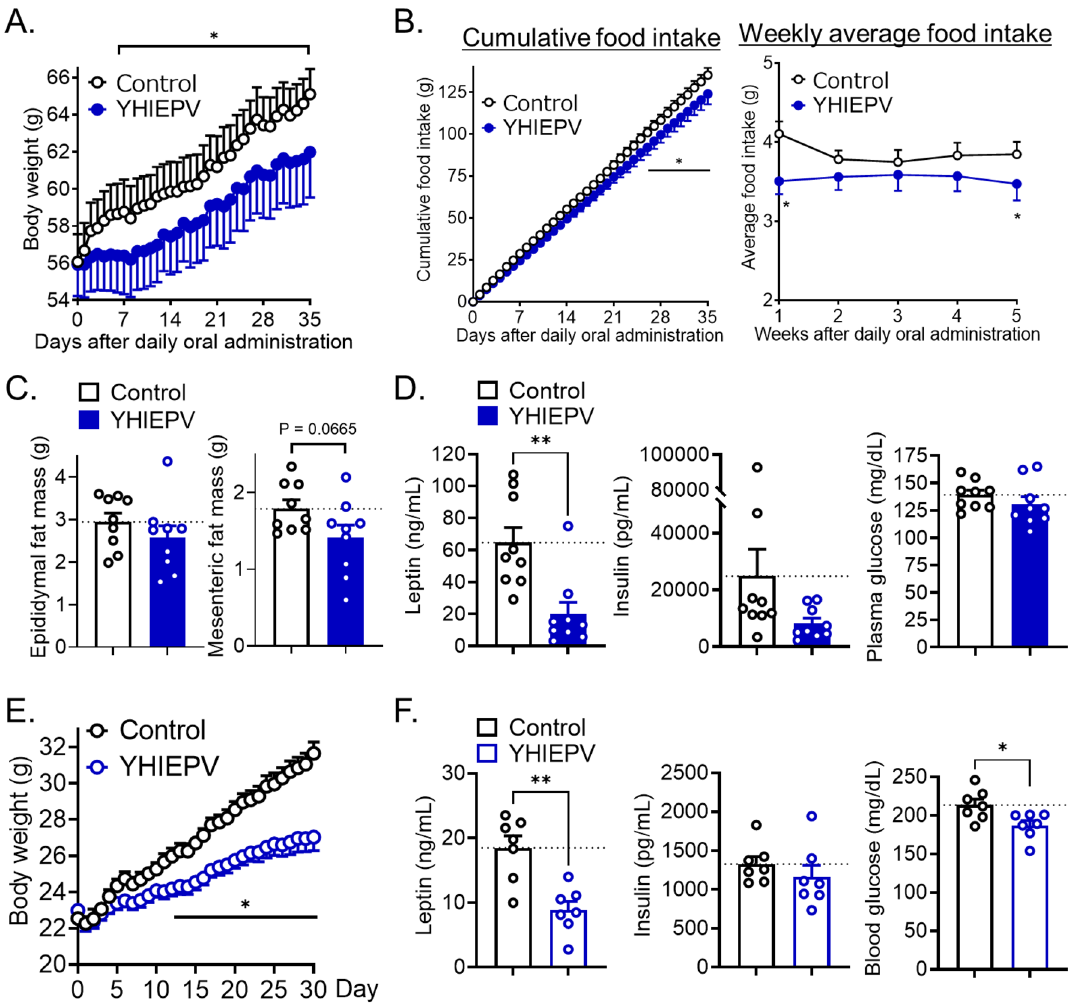
Figure 3. YHIEPV protects against dietary obesity. ( A – D ) Effects of YHIEPV on body weight and food intake in HFD-induced obese ddY mice. Body weight changes ( A ) and cumulative food intake or weekly average food intake ( B ). HFD-fed obese ddY mice (HFD for 2 months, n = 9/group) were orally administered YHIEPV (0.3 mg/kg for 35 days) once a day. Epididymal and mesenteric fat masses ( C ) and plasma leptin, insulin, and glucose levels ( D ) were measured on day 35. Mice were fasted for 3 h (from 8 to 11AM) before the collection of tissue and blood samples. ( E , F ) YHIEPV was centrally infused (1 μg, every day) into C57BL/6 mice (n = 7). HFD was initiated on day 0. Body weight ( E ) was measured daily. Plasma levels of leptin and insulin and blood glucose levels ( F ) were measured on day 30. Mice were fasted for 3 h (from 8 to 11AM) before the collection of blood samples. *p < 0.05, **p < 0.01, ***p < 0.001 for a two-way ANOVA followed by Bonferroni multiple comparisons tests in ( A – C ) or t -tests in ( D ) and ( F ). All error bars are